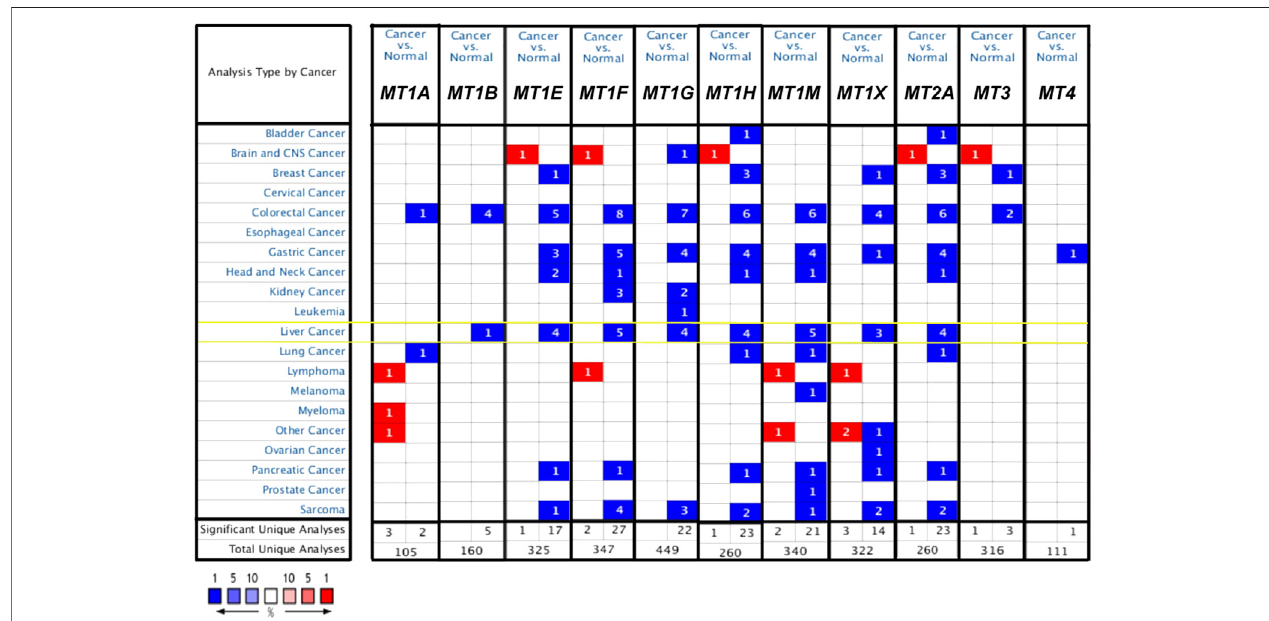
FIGURE1| mRNAexpressionlevelofMTsbetweencancerandnormaltumortissuesinmultiplecancersfromtheOncominedatabase.Thenumbersinthesquare represent the number of datasets that meet the threshold of fold change > 2 and p < 0.01. The color intensity in red or blue is in direct proportion to the statistically signi fi cant level of MT1H upregulation or downregulation, respectively. Importantly, MTs ’ expression changes in HCC are highlighted with yellow